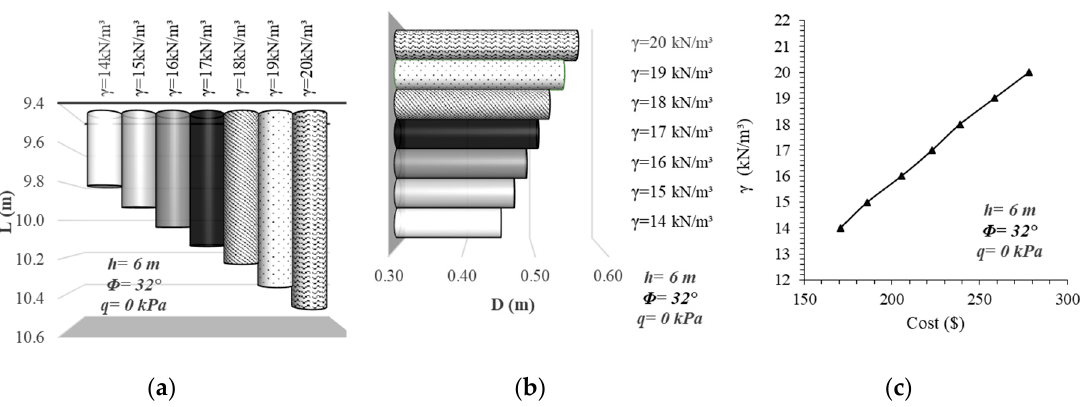
Figure 7. The effects of the change of soil unit weight to the diameter of the cantilever soldier pile ( a ), the length ( b ), and the unit cost of pile ( c ) (for h = 6 m excavation depth).